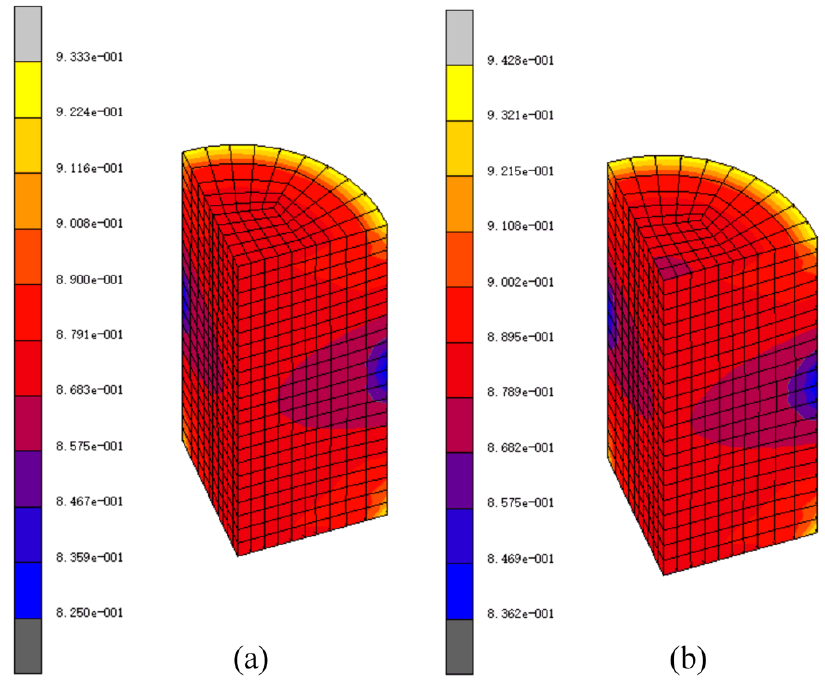
Figure 10. Relative density distribution in powder compacts with ( a ) loose initial packing structure with density ρ 0 = 0.56 and ( b ) dense initial packing structure with density ρ 0 = 0.62.